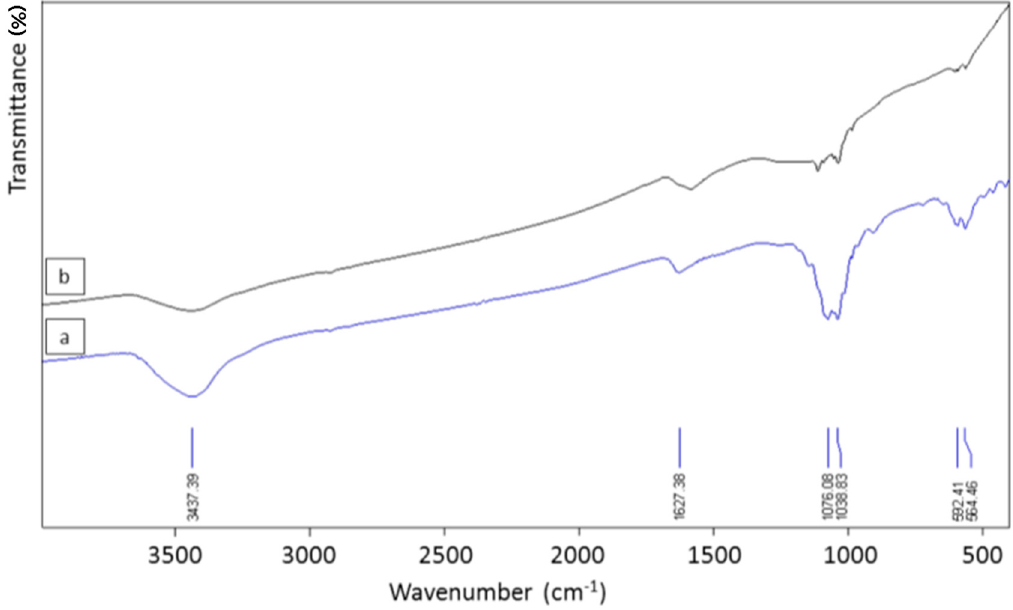
Figure 2. FTIR spectra of an AC (1 mg AC in 250 mg KBr) produced from rapeseed cake (S-900-120) before ( a ) and after ( b ) HCl washing.